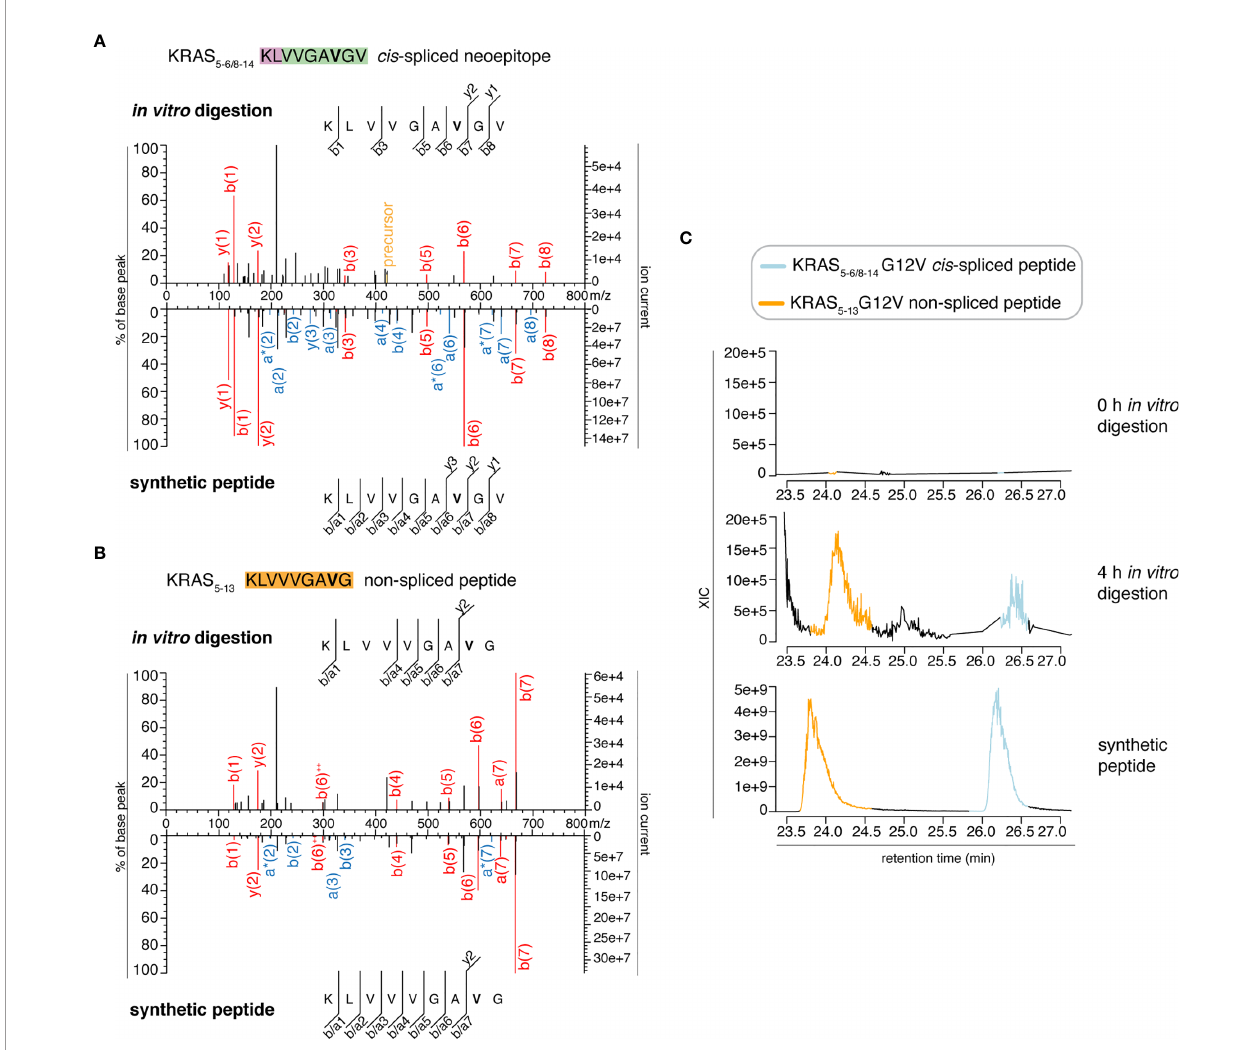
FIGURE 3 | Identi fi cation and quanti fi cation of KRAS 5-6/8-14 G12V cis -spliced and KRAS 5-13 G12V non-spliced peptides in in vitro digestion kinetics by standard MS through Q Exactive HF Orbitrap. (A, B) MS2 spectra of the KRAS 5-6/8-14 G12V [KL][VVGAVGV] cis -spliced peptide (A) and KRAS 5-13 G12V non-spliced peptide [KLVVVGA V G], which were identi fi ed in the 4 h in vitro digestions of the synthetic polypeptide KRAS 2-35 G12V with puri fi ed proteasomes, in comparison with the cognate synthetic peptides. The peptide sequence is shown with the corresponding b-, a- and y-ions identi fi ed. The G12V mutation is depicted in bold. In the spectra, assigned peaks for b-, a- and y-ions are reported in color. Ion neutral loss of ammonia and double charged ions are symbolized by * and ++ , respectively. Red marked peaks are assigned in MS2 spectra of both in vitro digestions and synthetic peptides, whereas blue marked peaks are assigned only in one of the two spectra. We marked the doubly charged peptide precursor in yellow. (C) Extracted ion chromatograms for the target peptides in the 0 h and 4 h in vitro digestion and the synthetic counterpart are plotted and indicate matching RTs and absence of a biologically signi fi cant peak in the 0 h digestion. MS ion chromatograms correspond to the m/z = 421.275 – 421.875. In (A – C) samples correspond to MF series carried out in HMDA buffer and have been measured through standard MS by Q Exactive HF Orbitrap mass